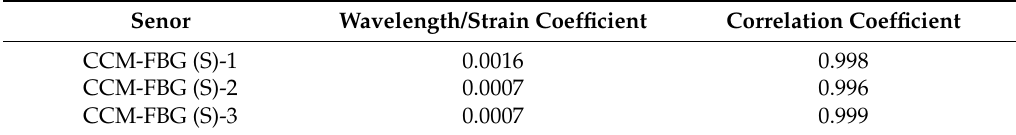
Table 1. Simple linear regression model of the wavelength/strain coefficient.